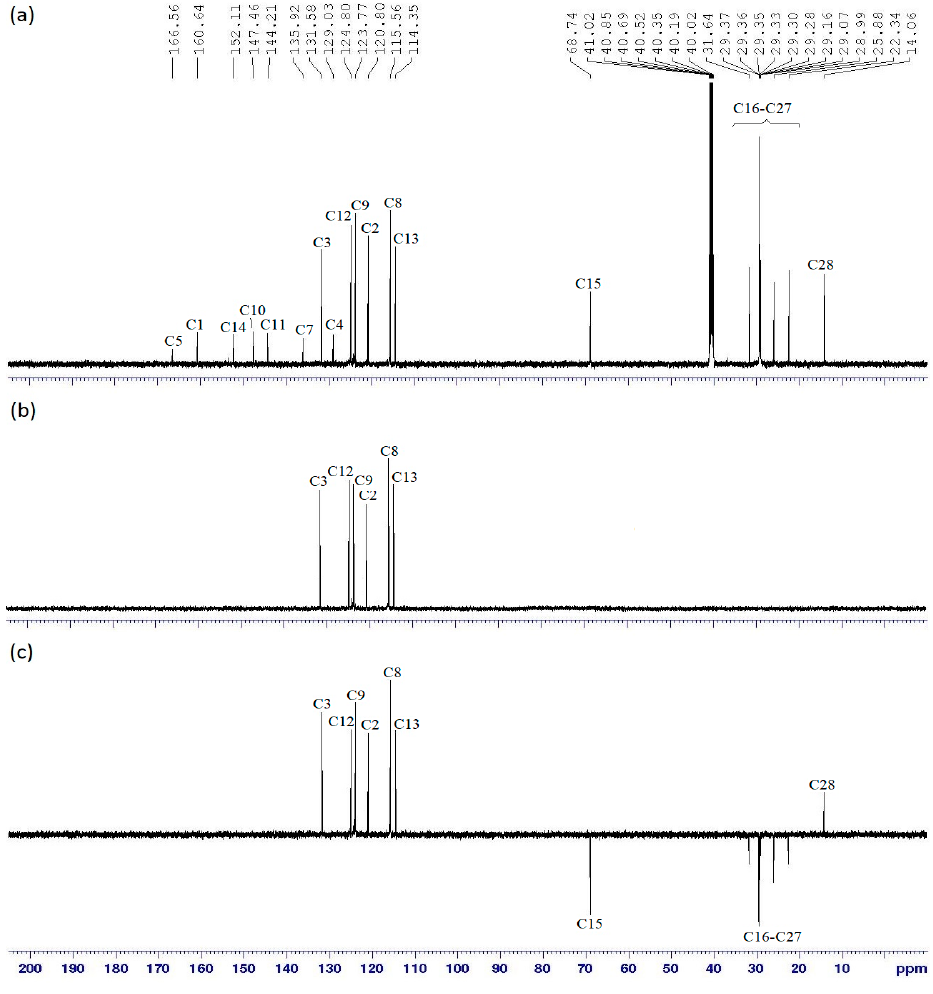
Figure 6. ( a ) 13 C-NMR, ( b ) DEPT-90, and ( c ) DEPT-135 spectra of compound 6e .